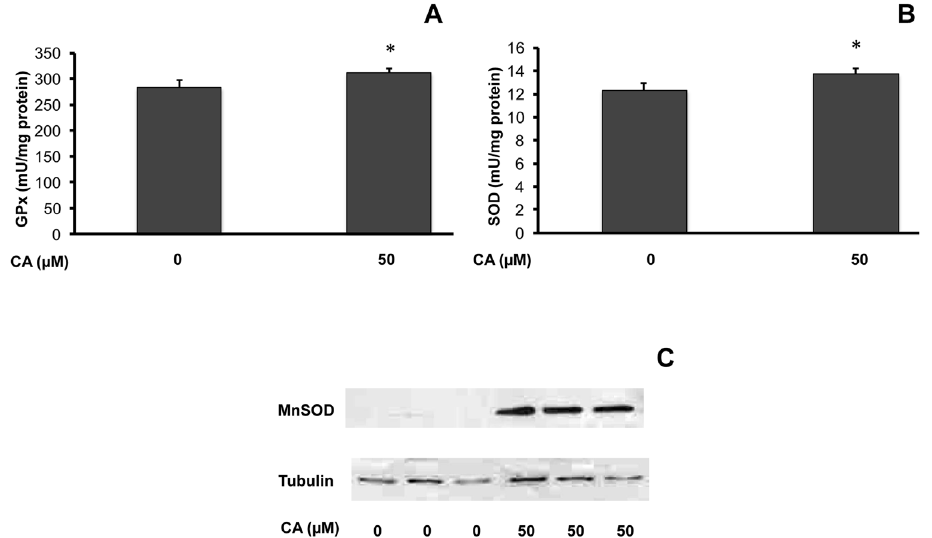
Figure 3. Influence of chicoric acid on antioxidant enzymes in L6 myotubes. Cells were cultured in the presence or absence of CA (50 m M) for 10 days before measurements of the enzymatic activities of GPx ( A ) or SOD ( B ), or analysis of MnSOD protein expression ( C ). Enzymatic activities are expressed as mU/mg protein and indicated as means 6 SEM (n=5); significantly different from control at * p , 0.05. Representative immunoblot is shown.